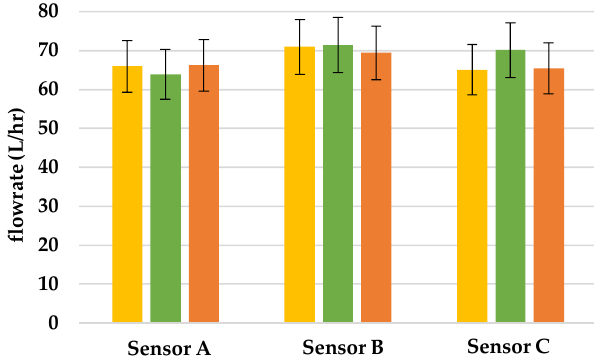
Figure 8. Flowrate of sensors when there is no leakage in the pipeline.